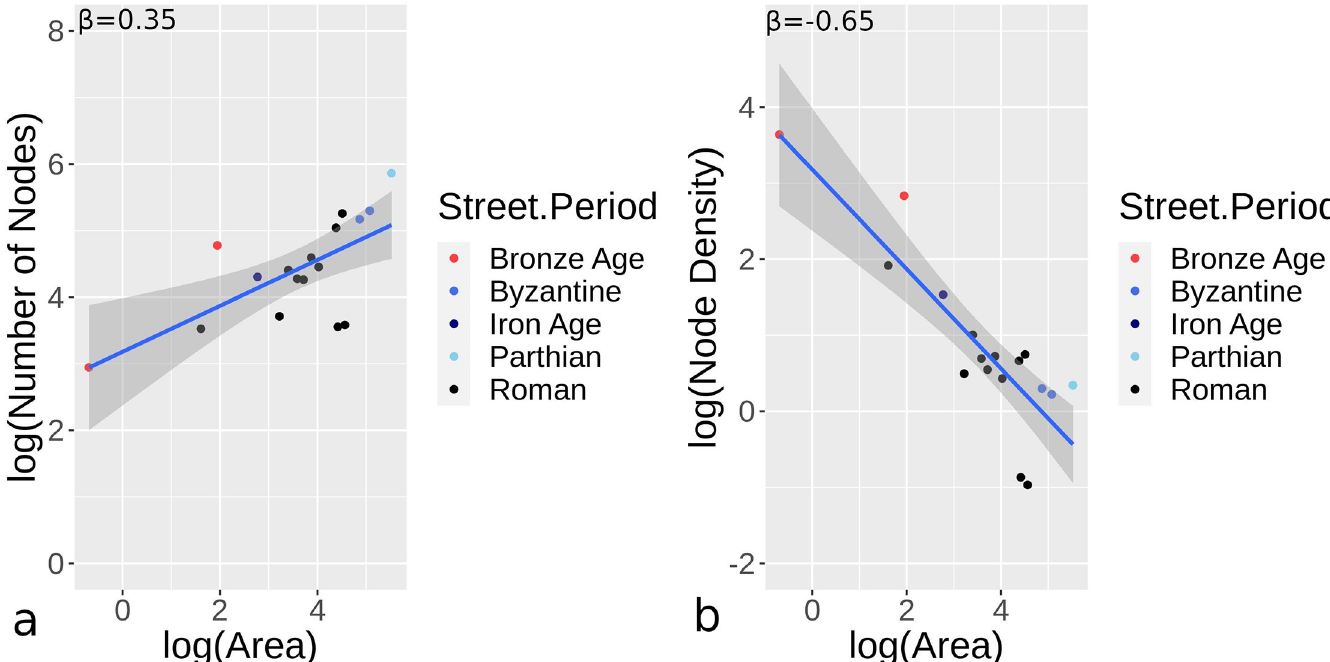
Fig 9. The scaling relationship for the number of nodes (a) and density (number of nodes/ha; b) for incomplete street network sites.